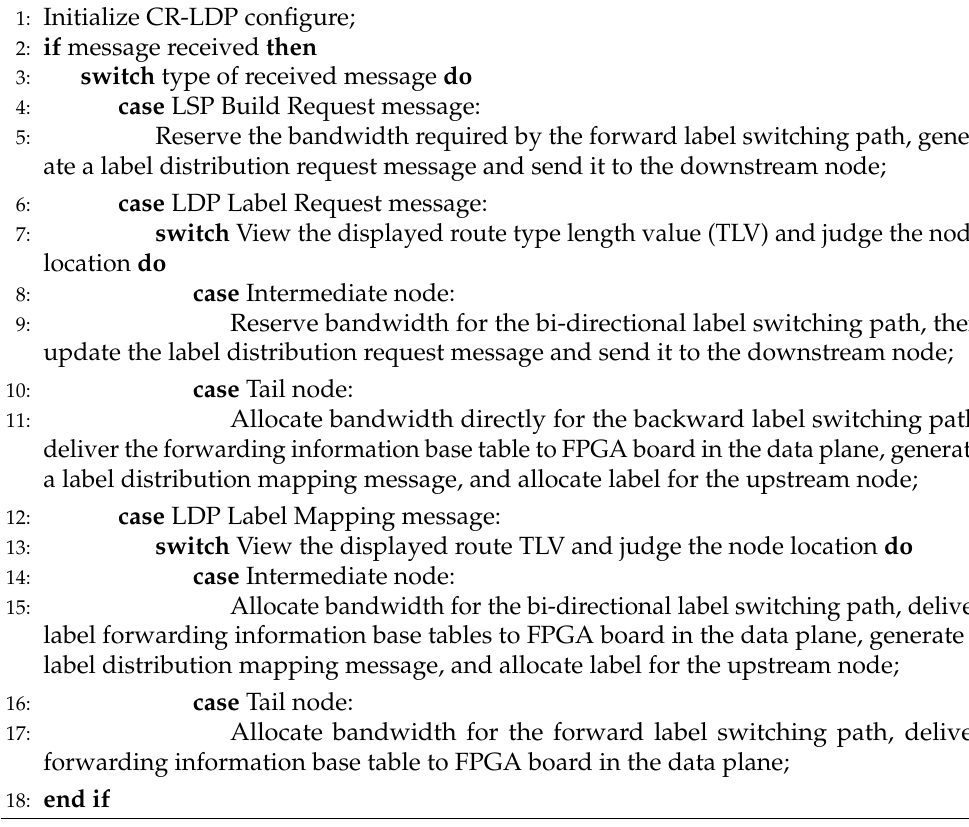
Algorithm 2 CR-LDP, Constraint Label Distribution under the QoS